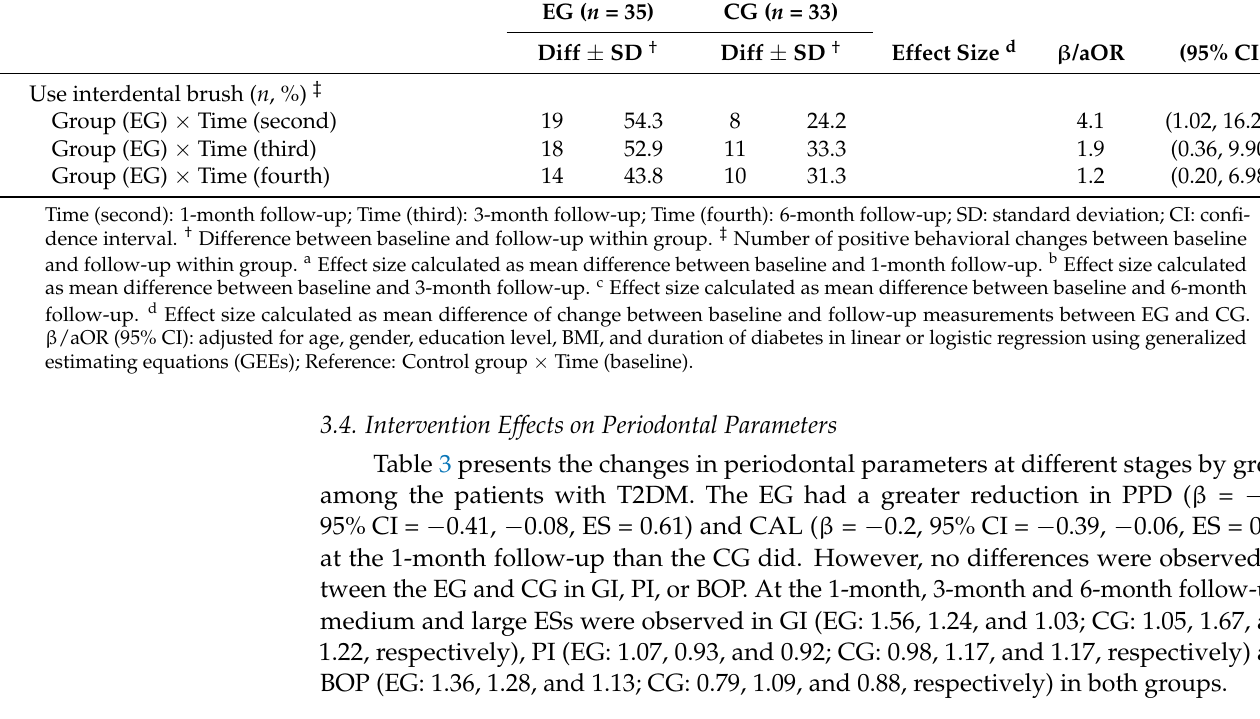
Table 3. Effect of changes in periodontal parameters at different stages (at baseline and at 1-month, 3-month and 6-month follow-up) by group among patients with